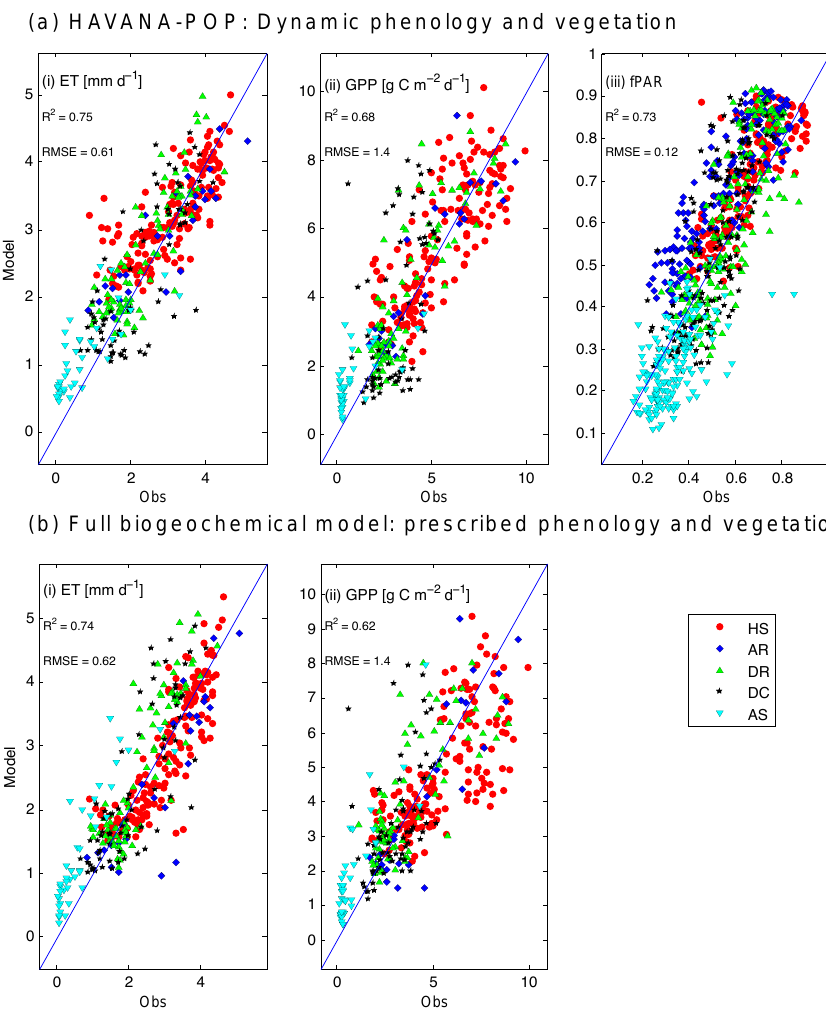
Figure 4. Scattergrams of model predictions vs. observations of monthly values at 5 flux sites of (i) ET, (ii) GPP, and (iii) fPAR. (a) HAVANA- POP and (b) CABLE in BIOS2, a full biogeochemical model with prescribed phenology and vegetation